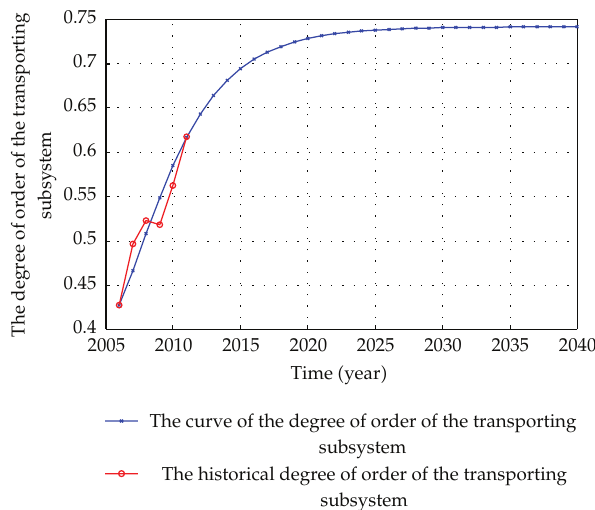
Figure 3: The synergy evolution curve of the degree of order of the transporting